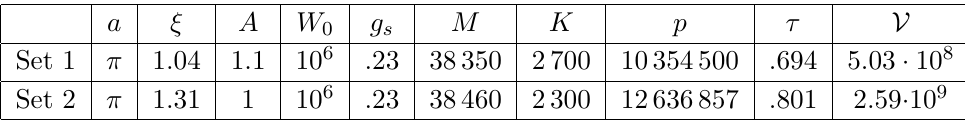
Table 1 . Two sets of parameters which give rise to two di(cid:11)erent in(cid:13)ationary regimes.